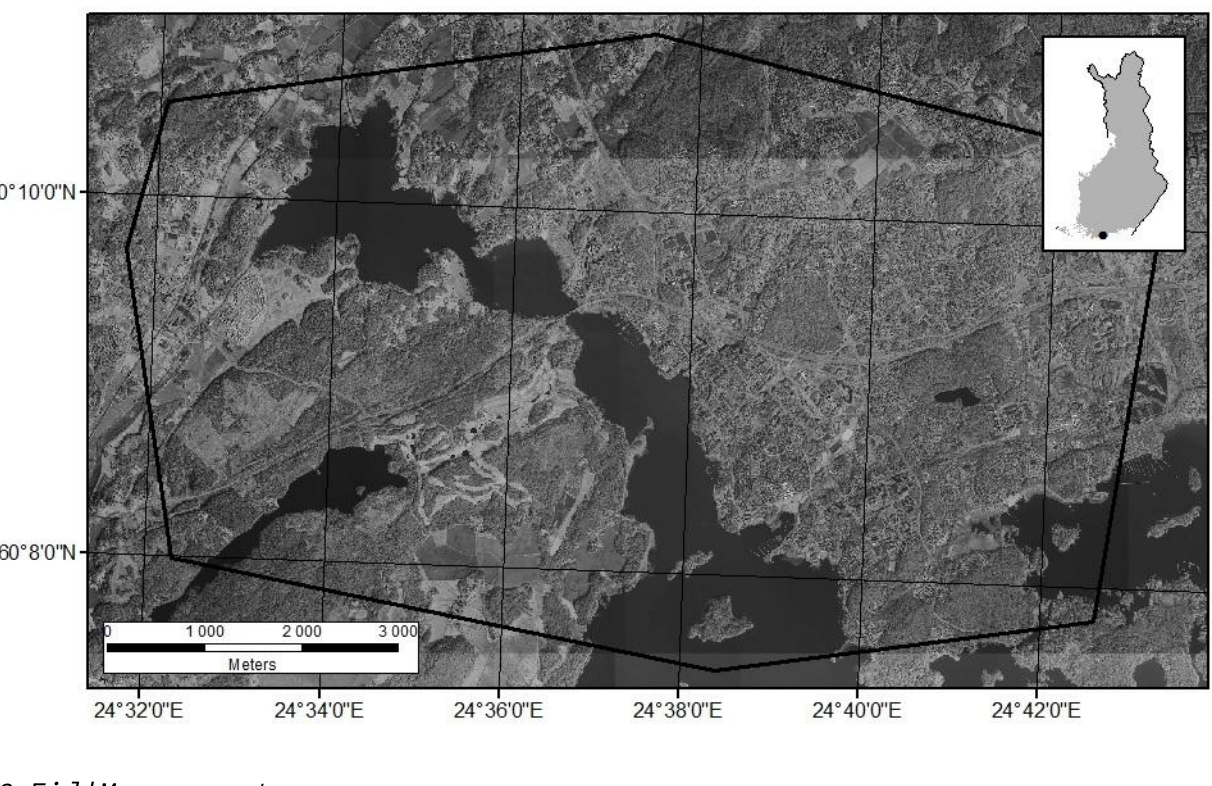
Figure 1. The area covered by TerraSAR-X stereoimages. The aerial orthophoto was acquired from the National Land Survey of Finland in March